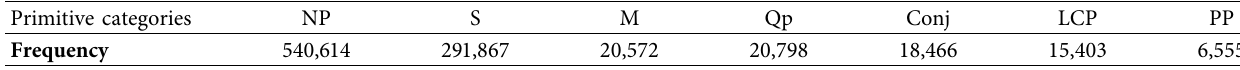
Table 1: Primitive categories in Chinese CCGbank (CASS).